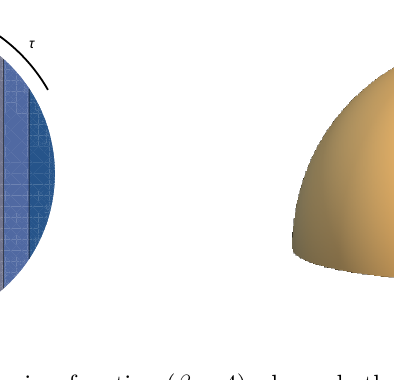
Figure 1 . The lowest lying eigenfunction ( (cid:12) = 4), shown both as a projection onto the plane, and also with the hemispherical geometry of the (cid:28) (cid:0) r (~ (cid:28) (cid:0) x ) section that makes a stronger link to the global analytic continuation (although here the radius of the suppressed S 2 is actually zero on the equator!)